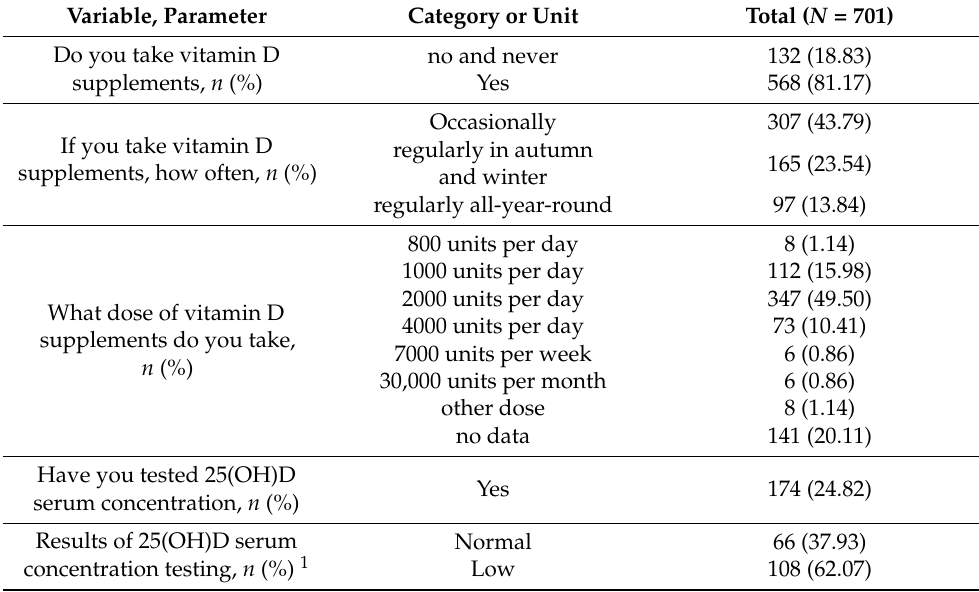
Table 4. Attitudes towards vitamin D